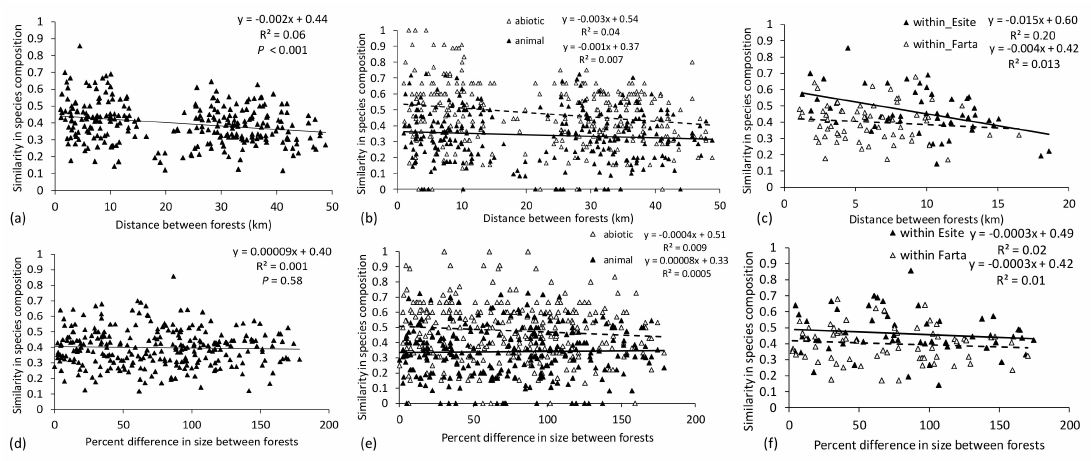
Figure 4. Similarity in woody plant species composition with distance between forests ( a – c ) and percent difference in size between forests ( d – f ) in Upper Montane forests for all plant species ( a , d ), for abiotic- dispersed and animal-dispersed species ( b , e ), and for all species within Woredas ( c , f ). Similarity in species composition was calculated using a Bray–Curtis index on an abundance matrix. Distance between forests was calculated using the great circle distance from the haversine distance.